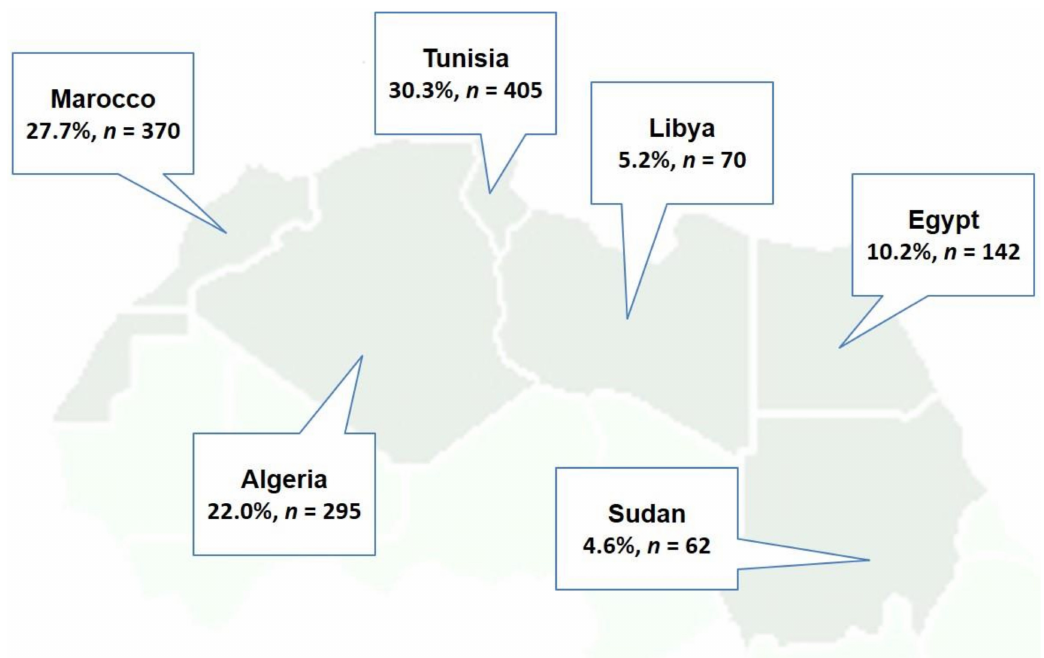
Figure 1. Frequencies of countries of origin of the North African migrant ED